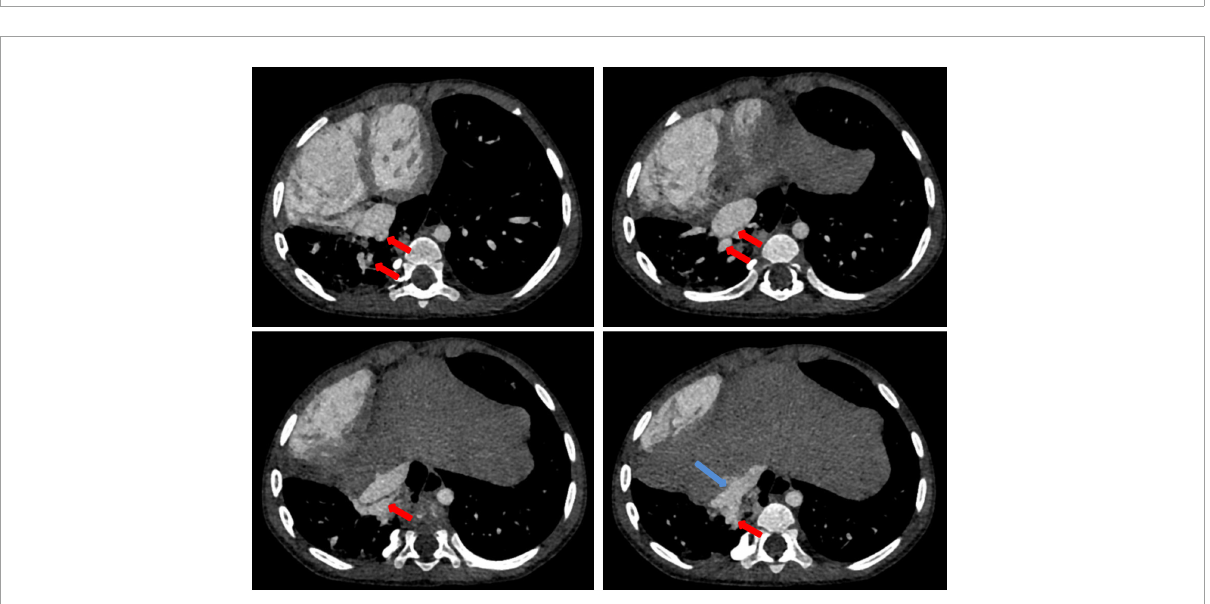
FIGURE2 Contrast-enhanced CT of the chest: contrast-enhanced CT shows the isolated pulmonary venous draining (red arrow) into the hepatic vein (blue arrow).